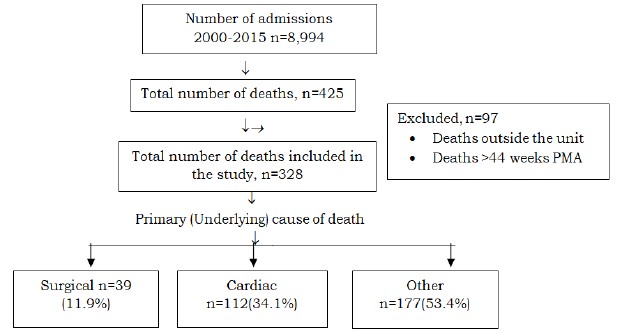
Figure 1- Flow chart depicting study design and outcome